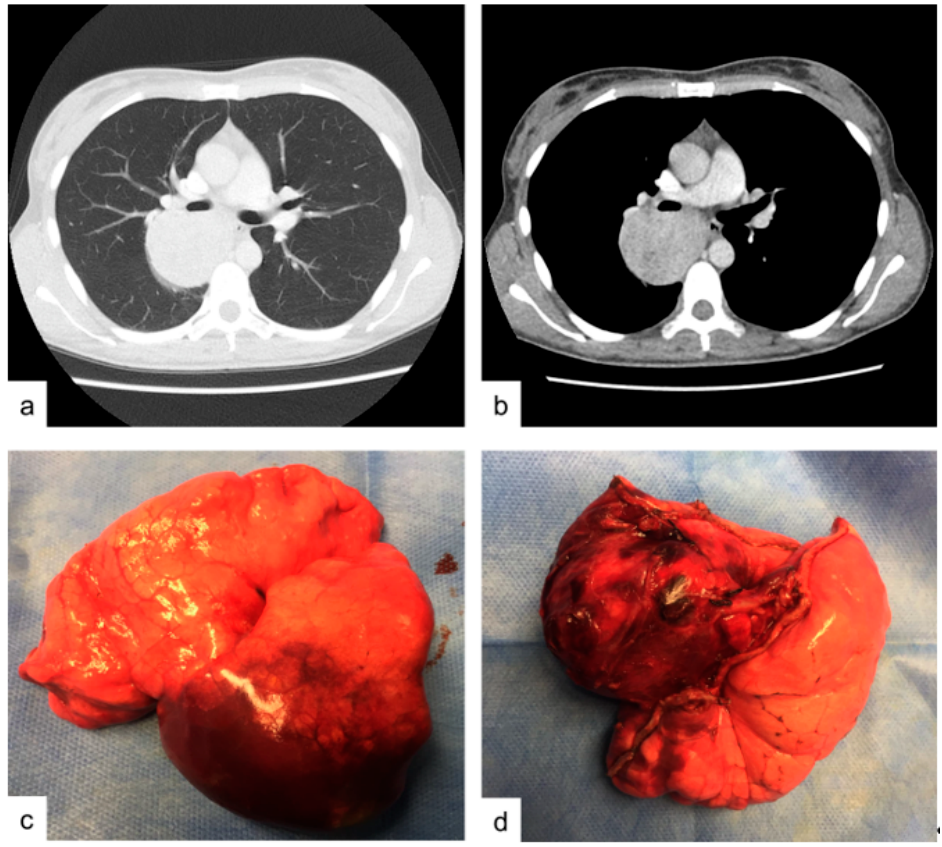
Figure 1. Case 1. ( a , b ) contrast enhanced chest CT-scan showing an hypodense soft-tissue lesion in the size of mm 50 by 65 mm located between the posterior segment of the right upper lobe and lower lobe upper segment. ( c , d ) operative specimen: right upper lobe and lower lobe upper segment after surgical excision.